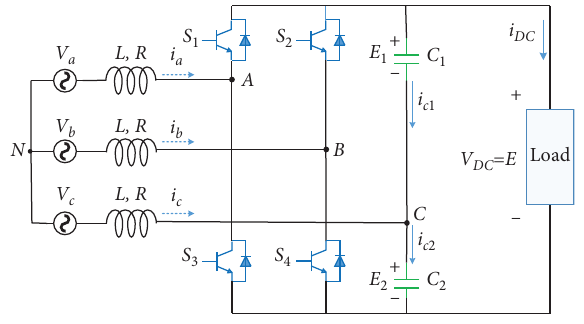
Figure 1: Topology of a